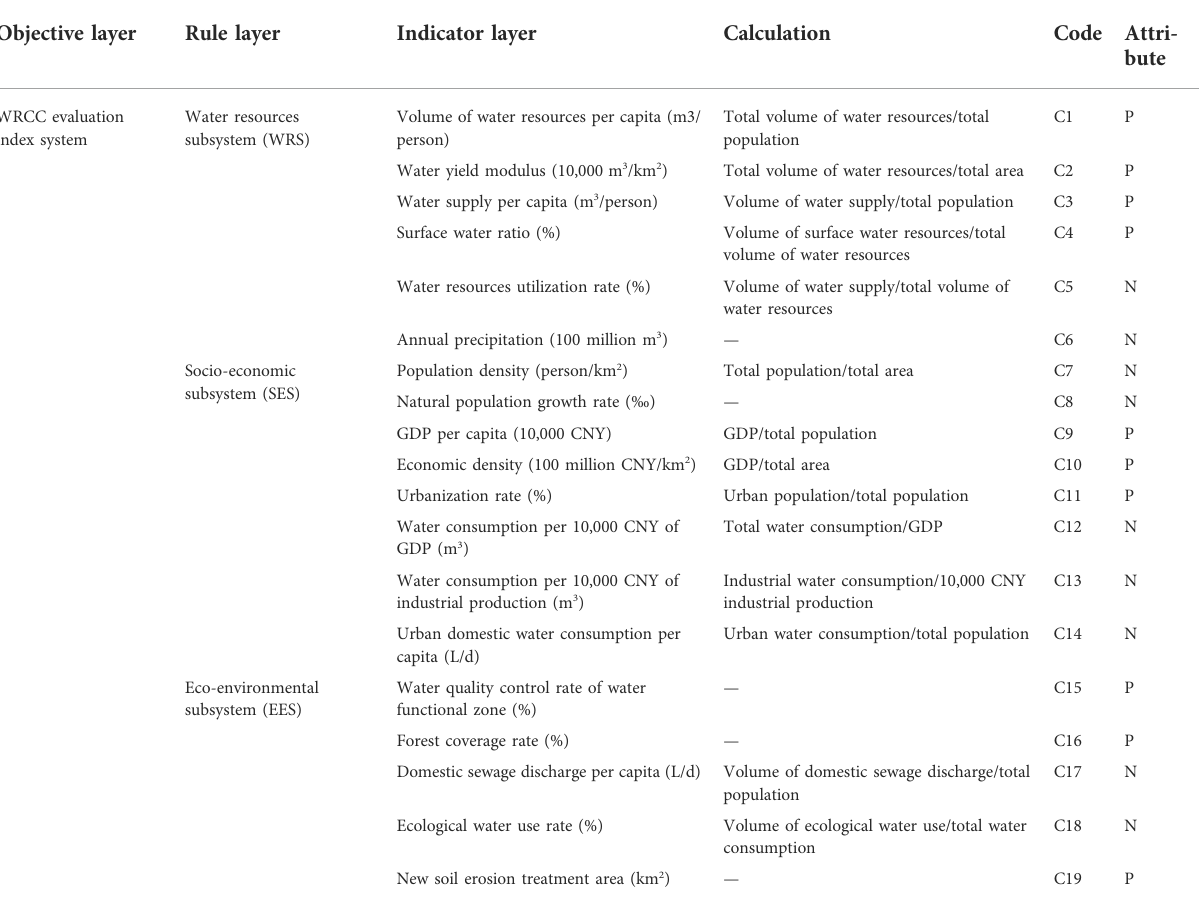
TABLE 1 WRCC evaluation index system for